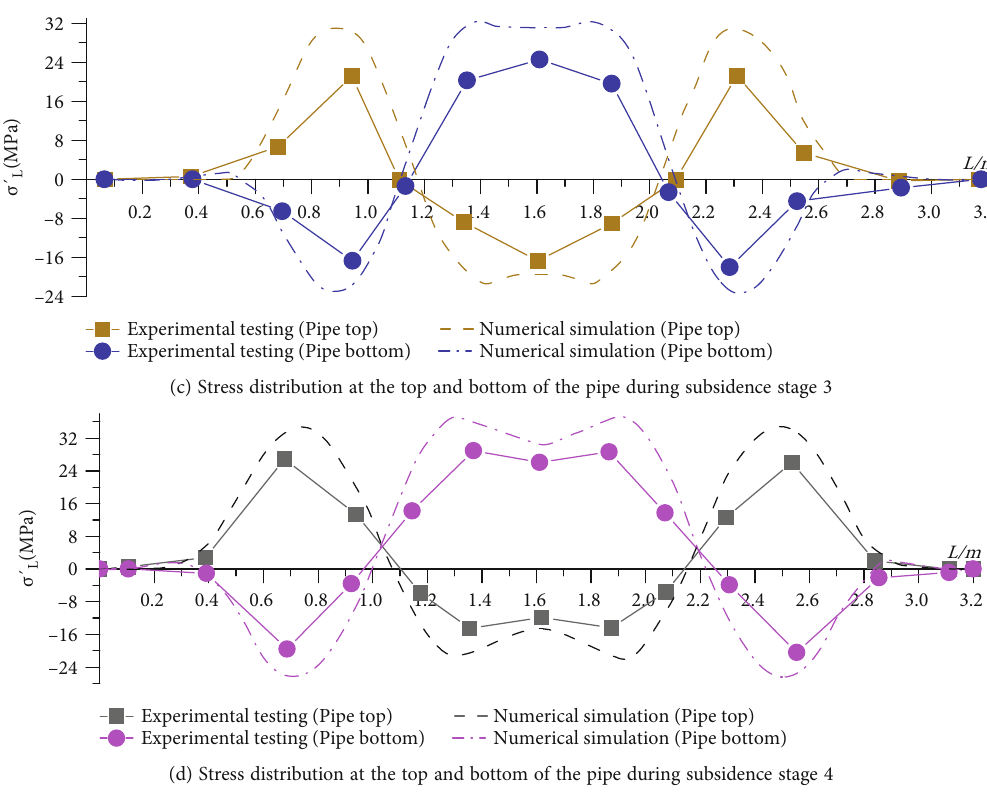
(d) Stress distribution at the top and bottom of the pipe during subsidence stage 4 Figure 14: Distribution of axial stress at top and bottom of